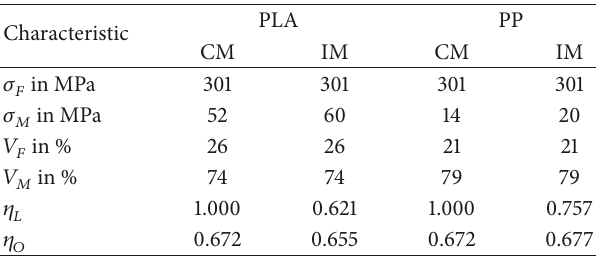
Table 2: Data used for tensile strength calculation with the Kelly- Tyson model according to (1).